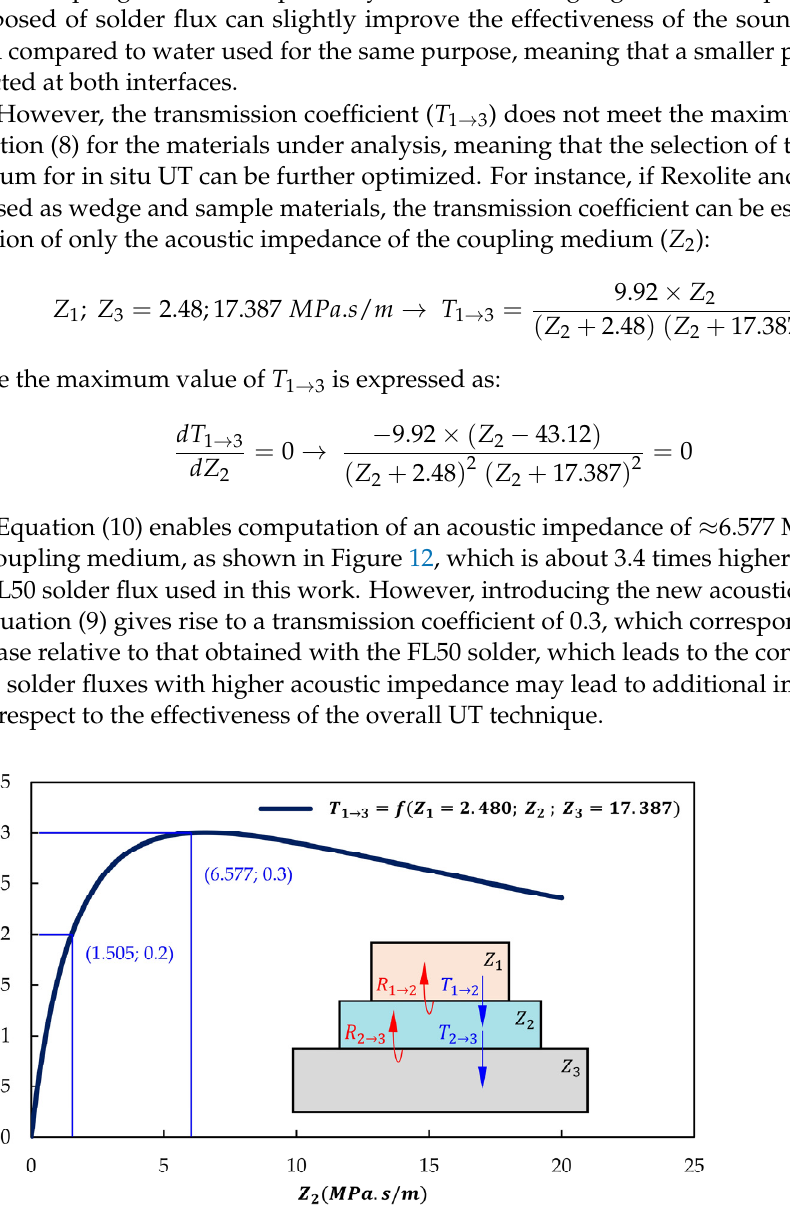
Figure 12. Transmission coefficient ( T 1 → 3 ) as a function of acoustic impedance ( Z 2 ) residing in the coupling medium with Z 1 and Z 3 equal to 2.48 and 17.377 MPa.s/m,